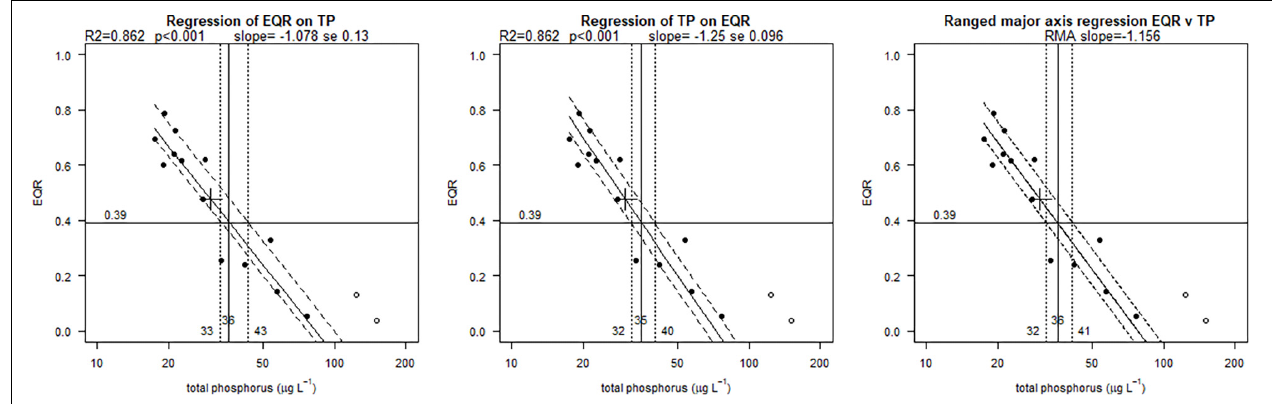
FIGURE 1 | Regressions with phosphorus (TP) for France (Mediterranean polyhaline coastal lagoons common type): OLS regression of EQR v log10 nutrient concentration; OLS regression of log10 nutrient concentration v EQR; (m) RMA type II regression of EQR v log10 nutrient concentration. Nutrient values back transformed for plotting. Solid points are the values used for models. Open circles are the excluded data (data beyond linear range). Black cross marks mean of data. Solid lines show fitted regression, broken lines upper and lower (25th, 75th) quantiles of residuals. Good/Moderate boundary point marked, as well as likely boundary range (25th,